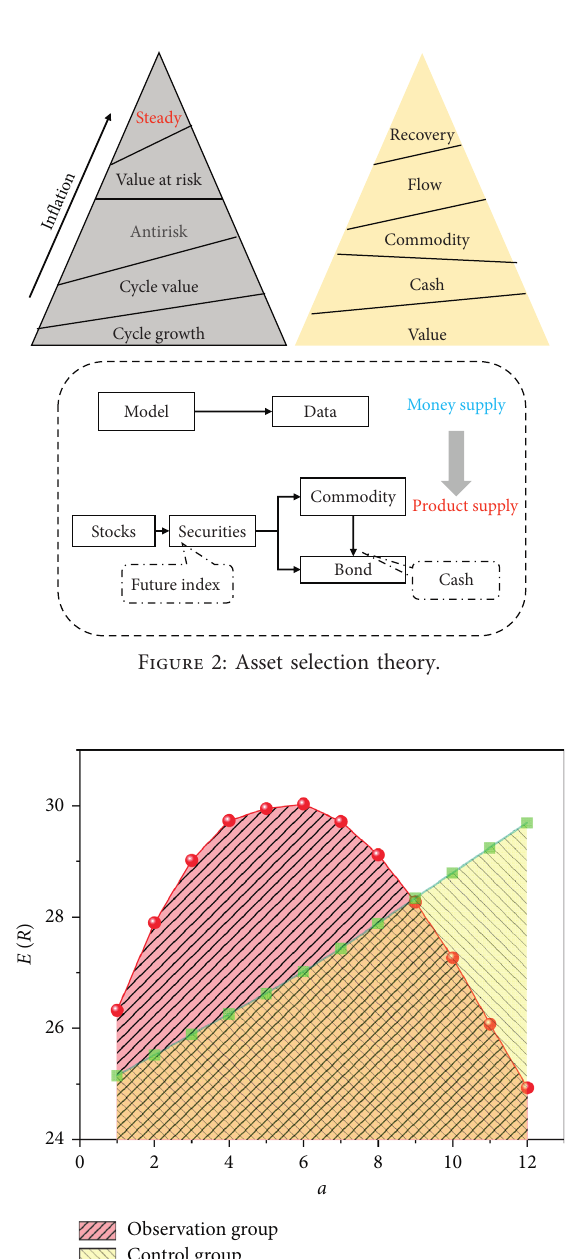
Figure 3: The function of the optimal point of the currency asset portfolio.